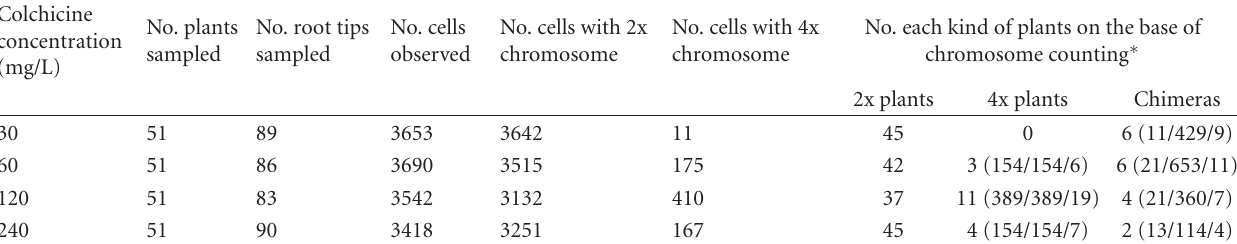
Table 2: Comparison of the e ff ect of colchicine concentration on chromosome doubling of regenerated plants.